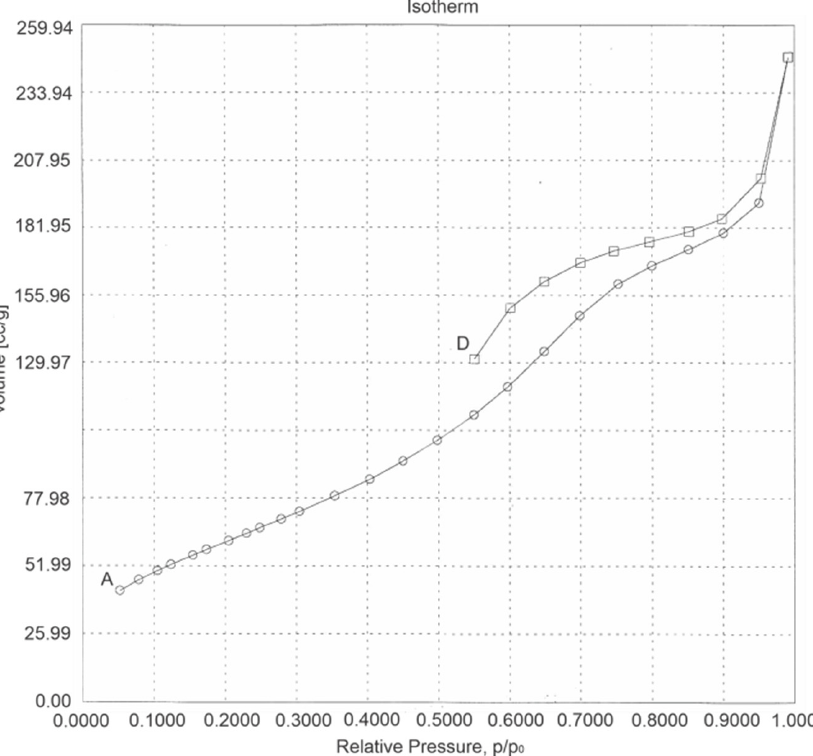
Figure 8. Brunauer-Emmett-Teller (BET) analysis of TiO 2 scaffolds, A—adsorption, D—desorption.